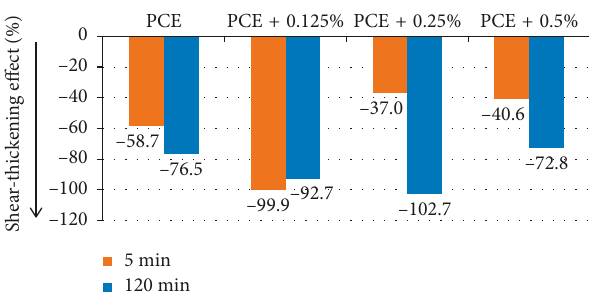
Figure 15: Shear-thickening behavior of nanomodified cement pastes with PCE within 5 and 120 min